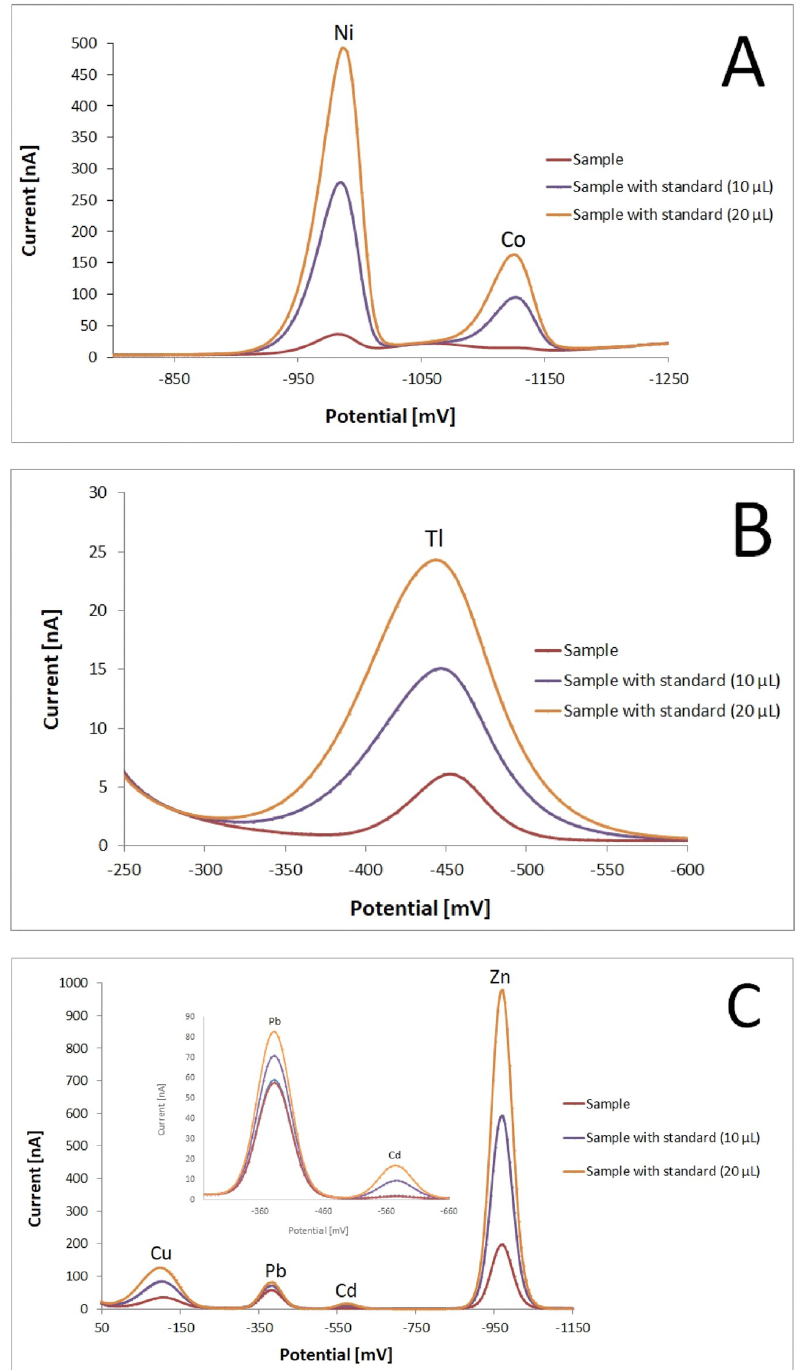
Fig 1. Heavy metal detection in Taraxacum officinale flowers collected in Warszawa 2. (A) Co and Ni determined by adsorptive cathodic stripping voltammetry (AdCSV) at hanging mercury dropping electrode (HMDE); (B) Tl determined by anodic stripping voltammetry (ASV) at hanging mercury dropping electrode (HMDE); (C) Zn, Cd, Pb and Cu determined by anodic stripping voltammetry (ASV) at hanging mercury dropping electrode (HMDE).